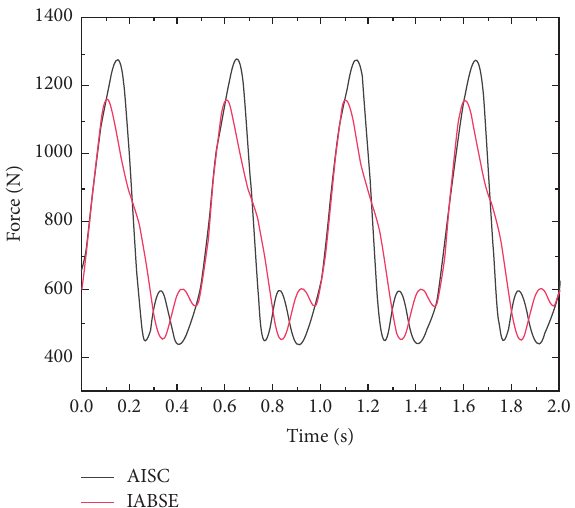
Figure 10: The time-history curve of walking load